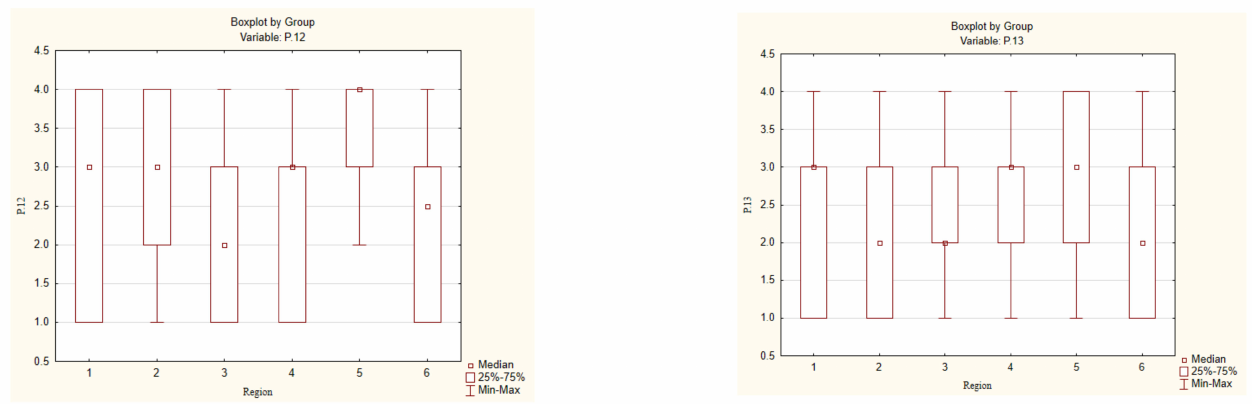
Figure 6. Box and whisker diagrams for practice P12 (Doing ironing collectively) and P13 (Setting a lower shower temperature), the category “energy